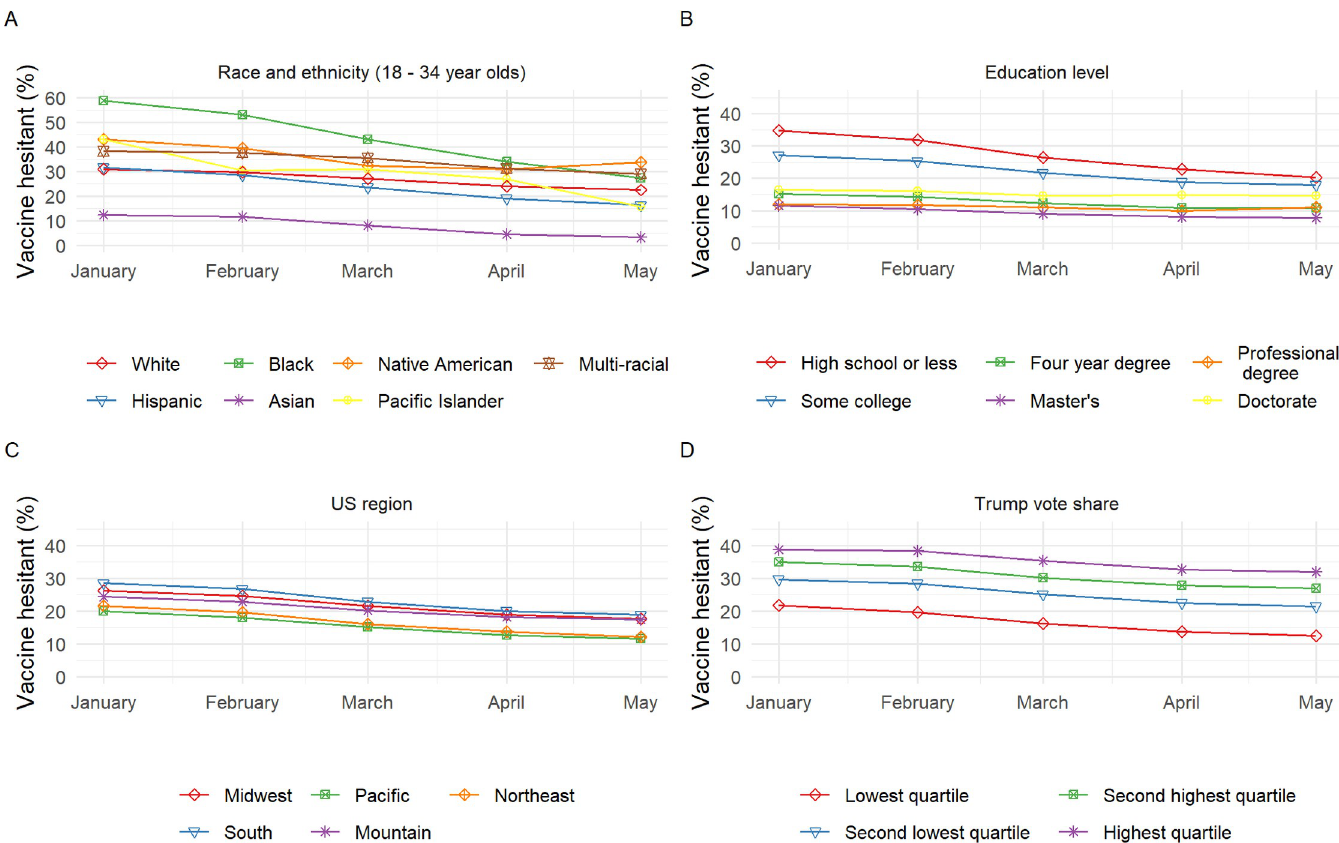
Fig 2. COVID-19 vaccine hesitancy by race/ethnicity (ages 18–34 years a ), education level, US region and county Trump vote share in the 2020 presidential election among US adults by month (January-May, 2021). Between January and May, the gap in percent hesitant between race/ethnicity groups among adults 18–34 years (panel A) and education levels among all ages (panel B) decreased, with the biggest decreases among the most hesitant groups (e.g., Black race and � high school education, respectively). Changes in percent hesitant over time were fairly similar across US regions (panel C); however, there was a slightly smaller decrease in the Mountain region and slightly larger decrease in the South versus other regions. The gap in percent hesitant by county political environment, quantified in quartiles of percent Trump vote share in the 2020 presidential election, increased slightly between January and May, with the most hesitant group (highest quartile) having the smallest decrease (panel D). a There was a significant interaction between race/ethnicity group and age group. Vaccine hesitancy for all race/ethnicity groups by all age groups is provided in S6 Table .